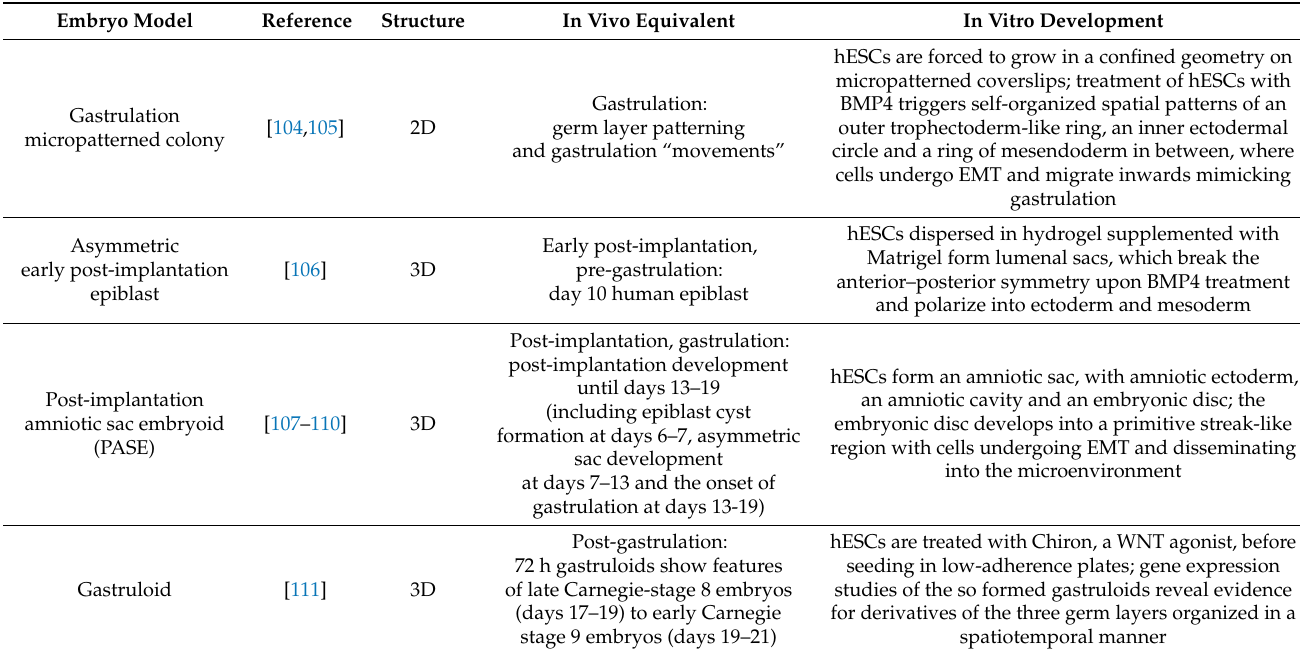
Table 1. Summary of hPSC-based in vitro embryo